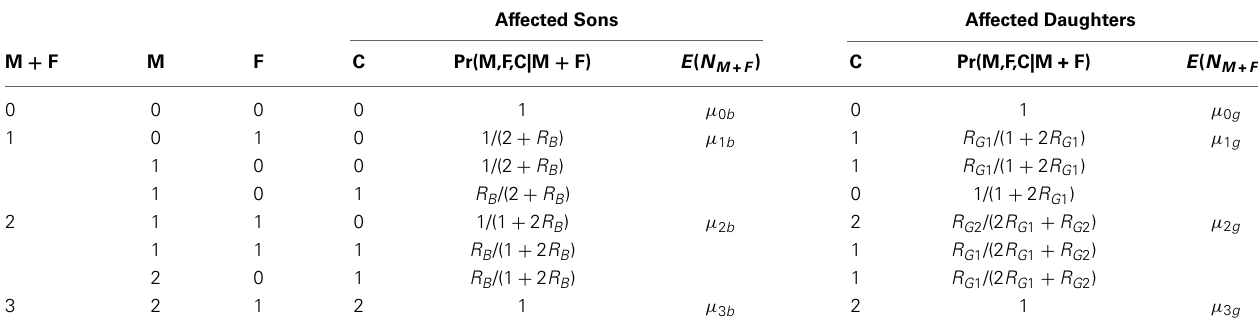
Table 4 | For affected sons and daughters, case-parents genotype probabilities using parental sum